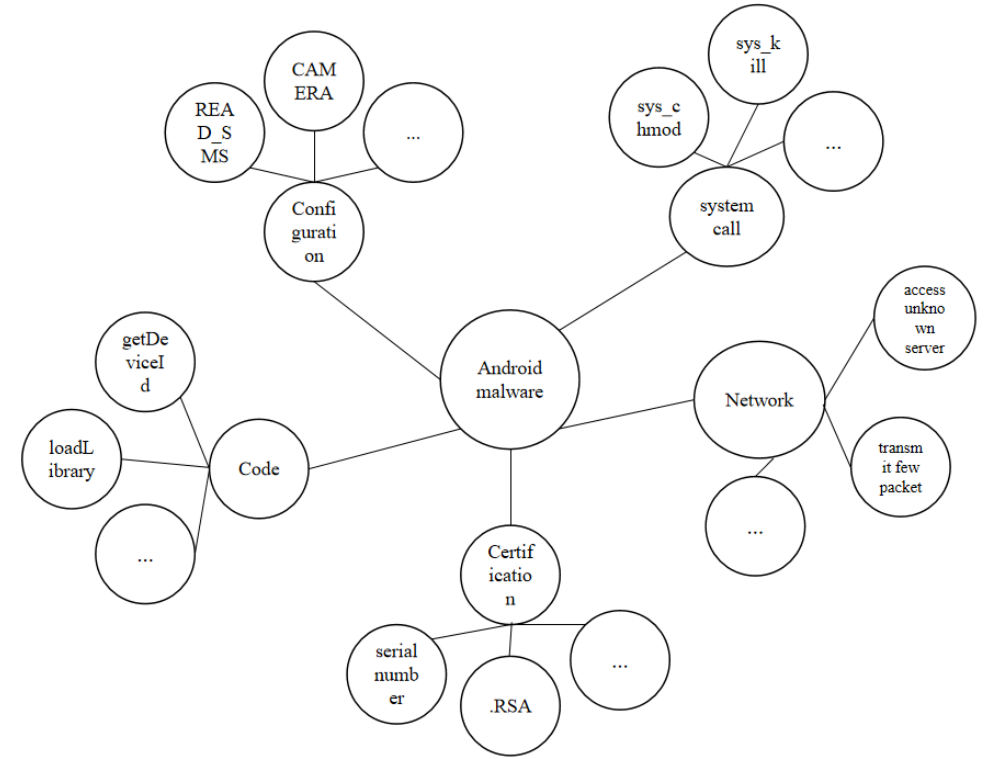
Figure 4. An example of Android malware behavioral tag.